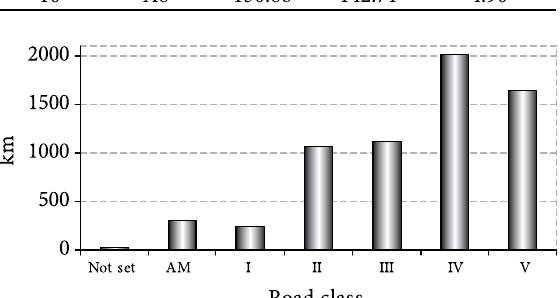
Table 2. The figures for valid car accidents on Lithuanian main and interurban road networks during the interval from the year 2002 to 2006 considering a type of an accident Type of an accident